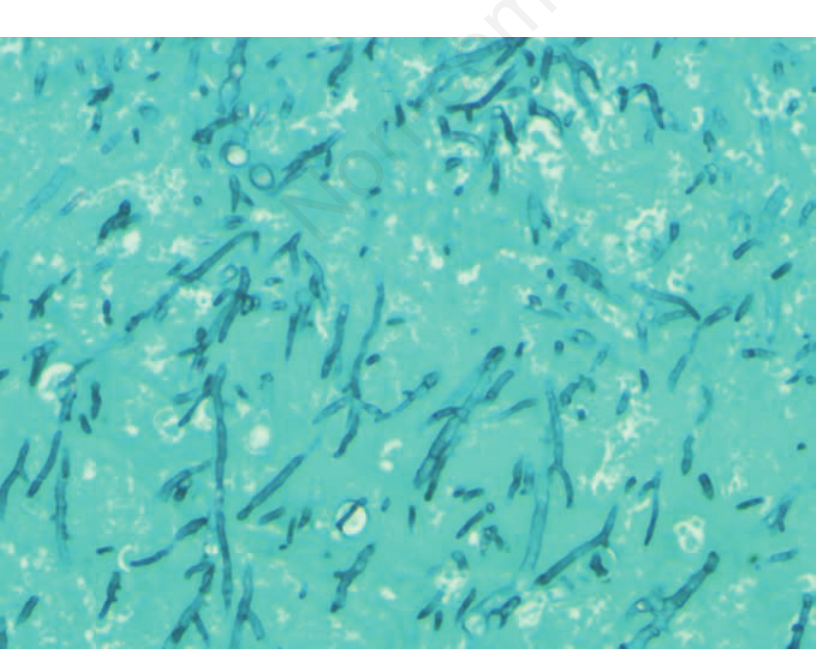
Figure 3. Grocott’s methenamine silver stain of the ascending aorta displaying the branching hyphae of Aspergillus fumigatus